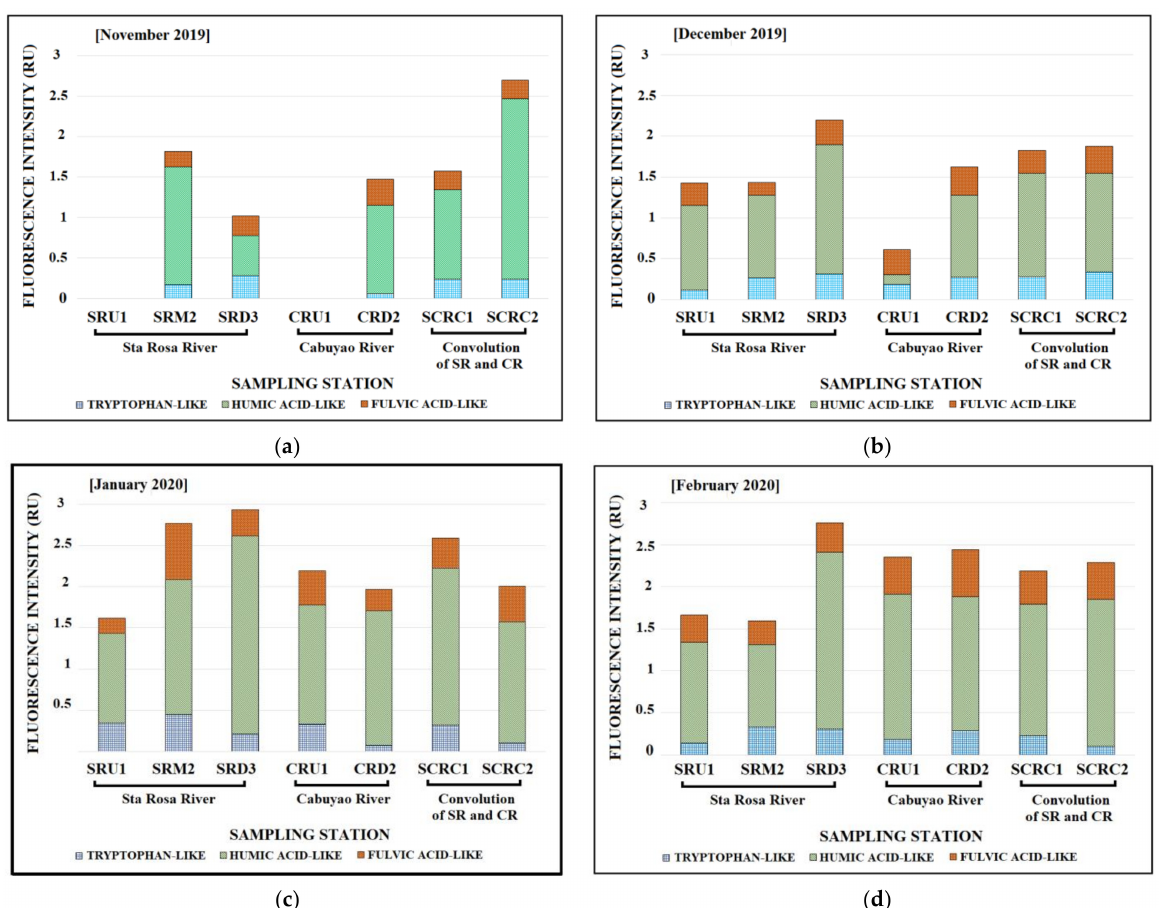
Figure 4. Distributions of DOM components in SR and CR. DOM components such as Tryptophan- like (T), humic acid-like (C), and fulvic acid-like (A) were measured for all sampling stations in the